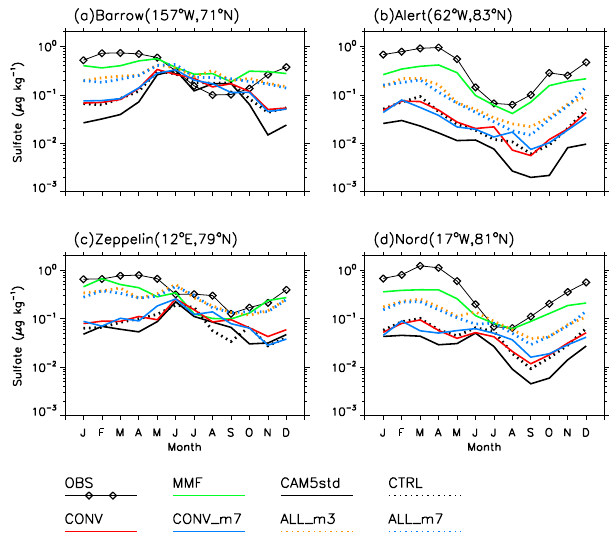
Fig. 4. Observed and modeled monthly mean non-sea-salt sul- phate mixing ratios (µgkg − 1 ) at the four Arctic sites: (a) Barrow, (b) Alert, (c) Zeppelin, and (d)